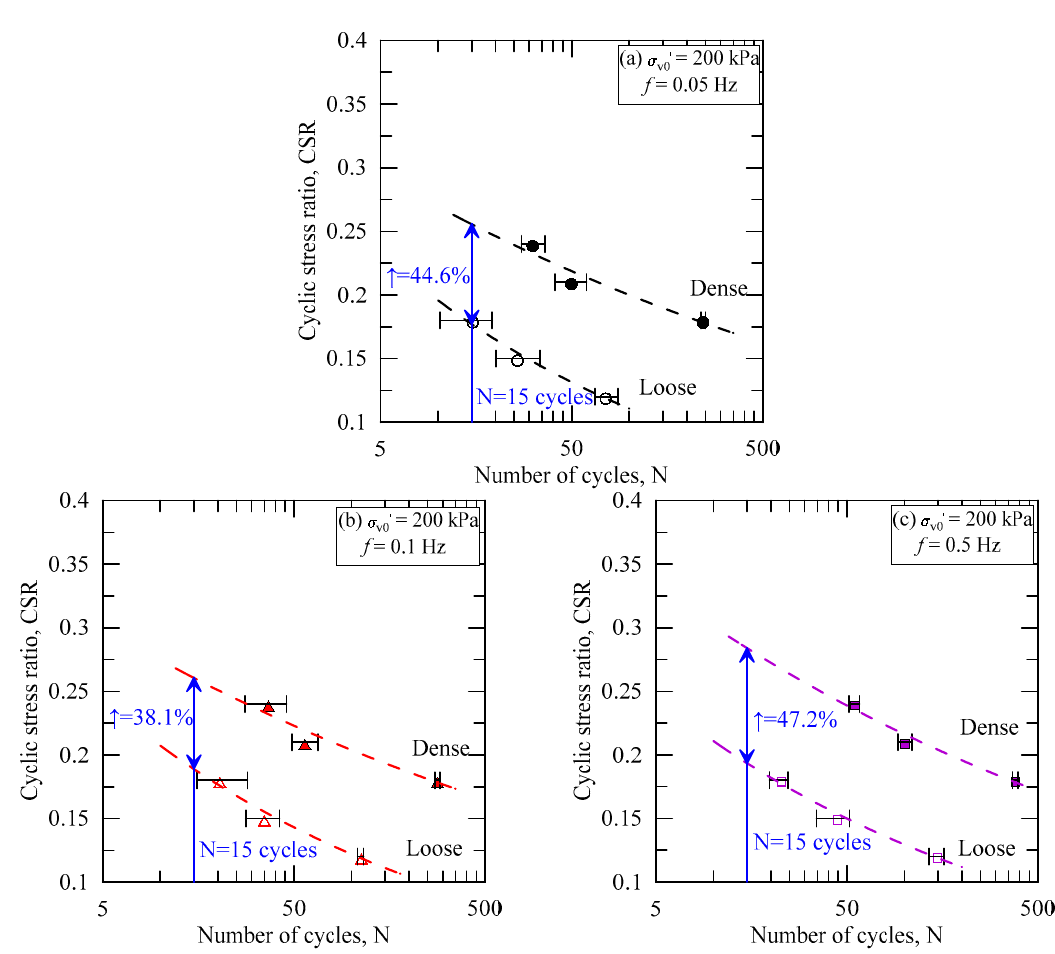
Figure 7. Comparison of cyclic resistance curves ( a ) f = 0.05 Hz, ( b ) f = 0.1 Hz and ( c ) f = 0.5 Hz at different density states for σ v0 ′ = 200 kPa.